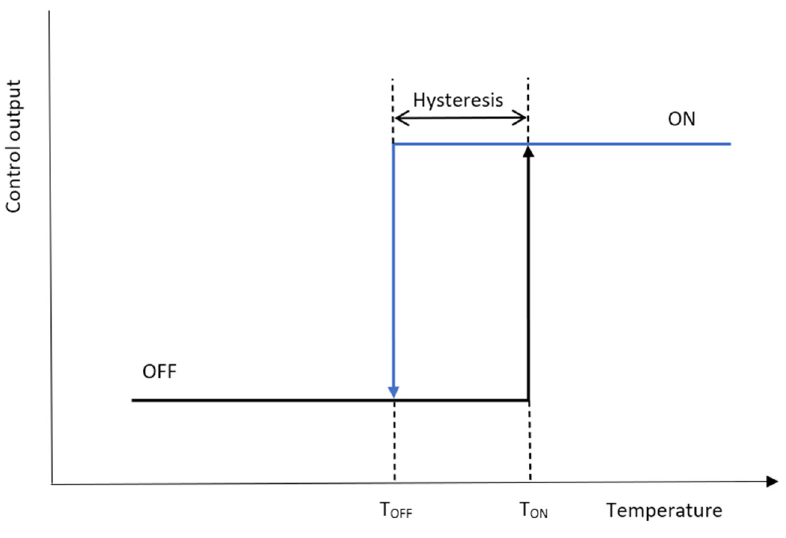
Figure 3. The ON-OFF control scheme.